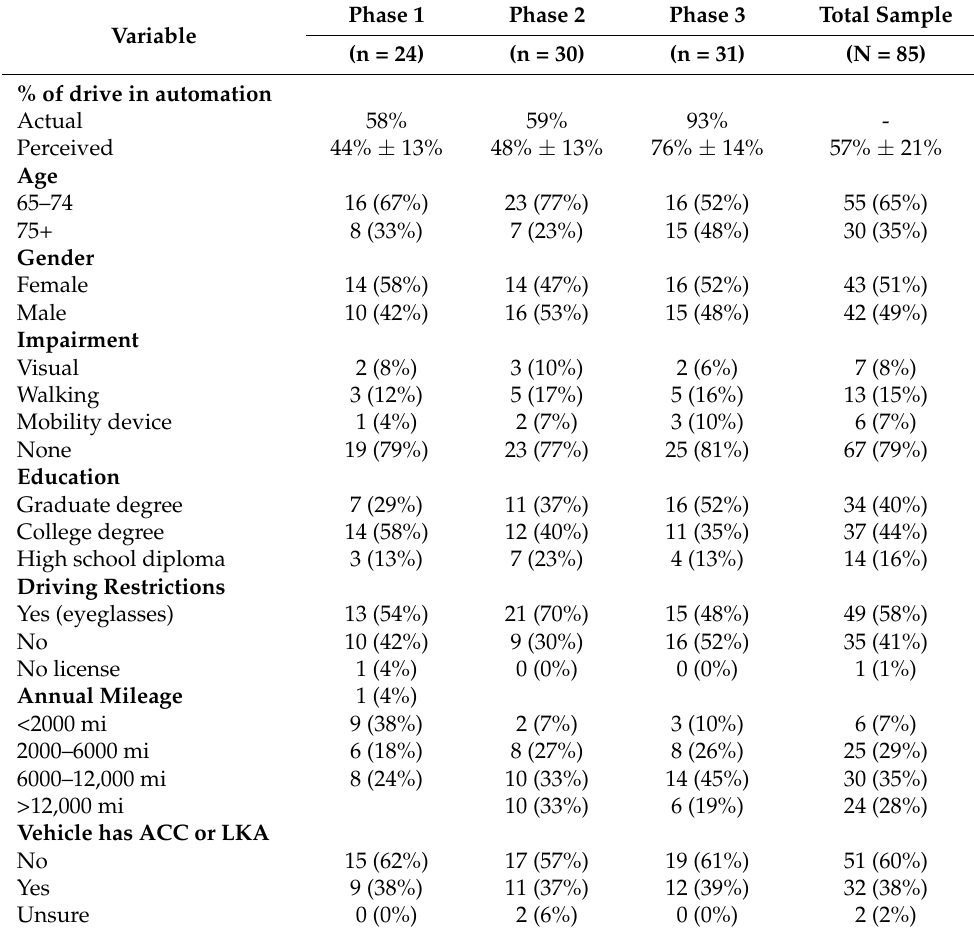
Table 1. Demographics and transportation preferences by